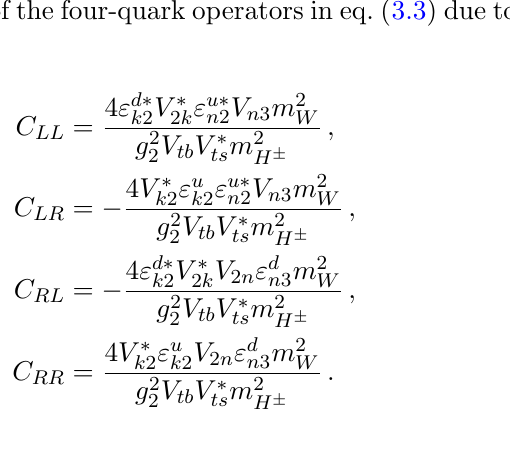
Figure 2 . Feynman diagrams showing the 2HDM contribution to C ( 0 ) eq. (3.11) and eq.